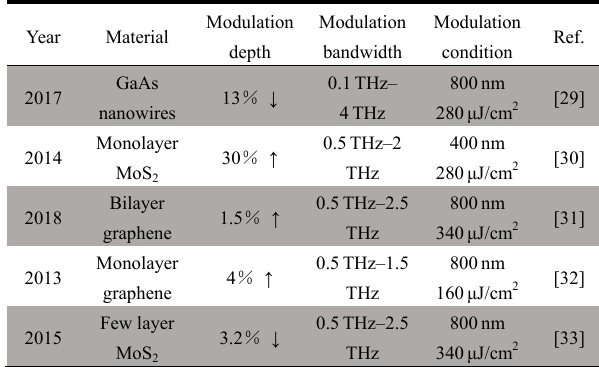
Table 1 Some optically controlled THz modulators based on 2D material system.